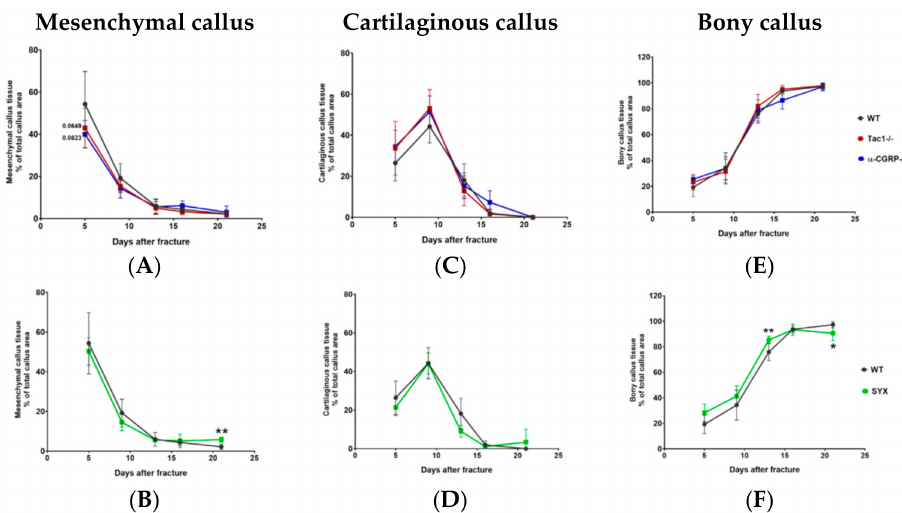
Figure 4. Callus maturation during fracture healing. Area of mesenchymal ( A , B ), cartilaginous ( C , D ) and bony ( E , F ) callus tissue during fracture healing in Tac1 − / − , α -CGRP − / − ( A , C , E ), SYX ( B , D , F ), and WT mice ( A – F ) at the time points 5, 9, 13, 16, and 21 days after fracture. Values were calculated as a percentage of total callus area and are presented as mean ± SD. * / ** / p -Values in black indicate di ff erences between neurotransmitter deficient and SYX mice to WT. * = p ≤ 0.05; ** = p ≤ 0.01. N =